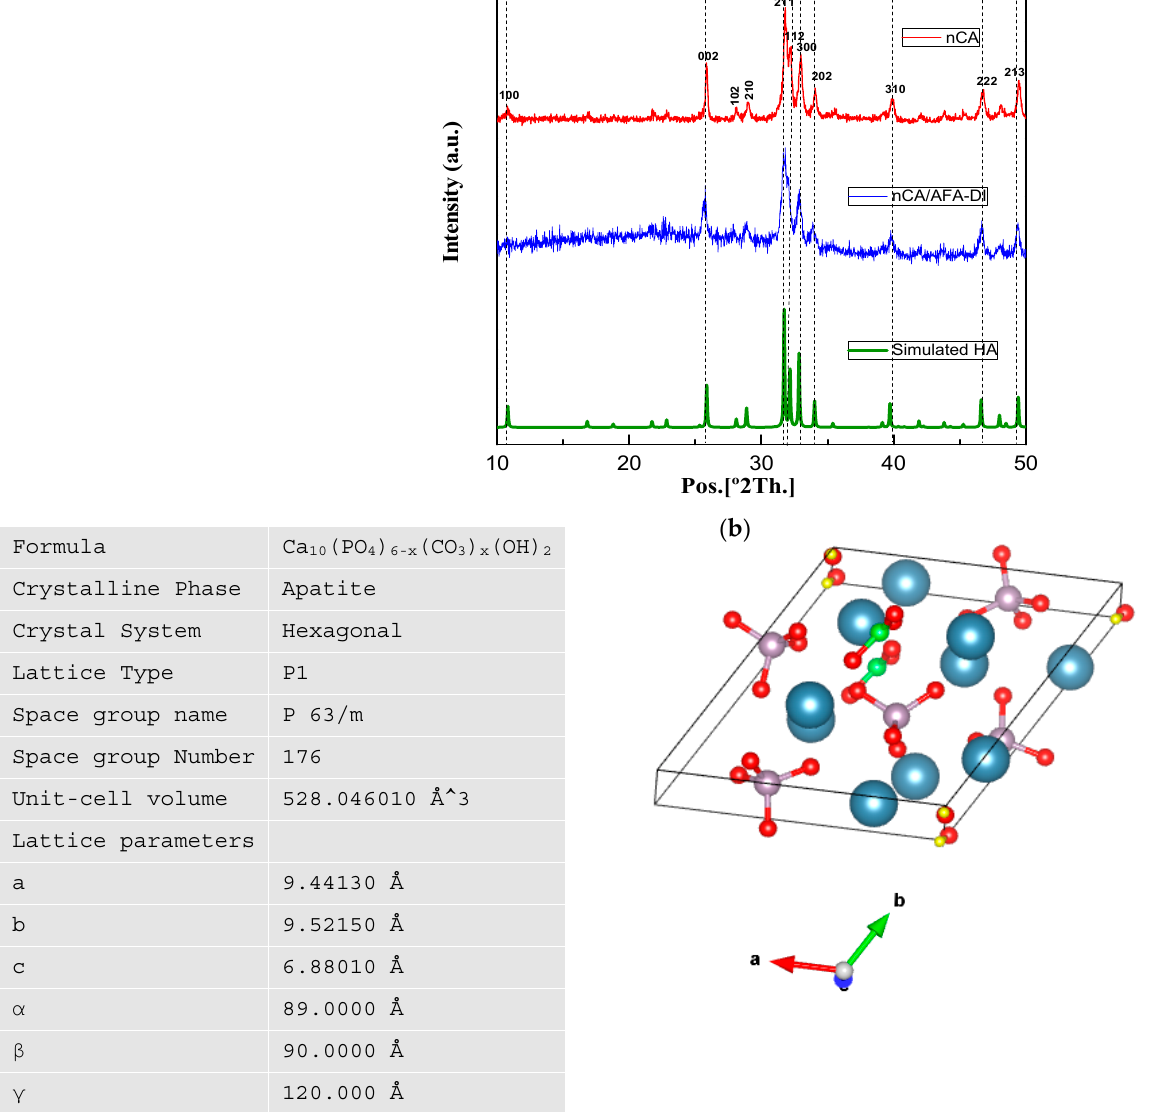
Figure 2. PXRD spectra of nCA and nCA/AFA. ( a ) PXRD patterns of nCA (red), nCA/AFA (blue), and simulated HA (green). ( b ) Hexagonal crystalline morphology of the synthesised nCA, with calcium (blue), phosphorous (purple), carbon (green), oxygen (red), and hydrogen (yellow), using the Vesta program and its lattice parameter.